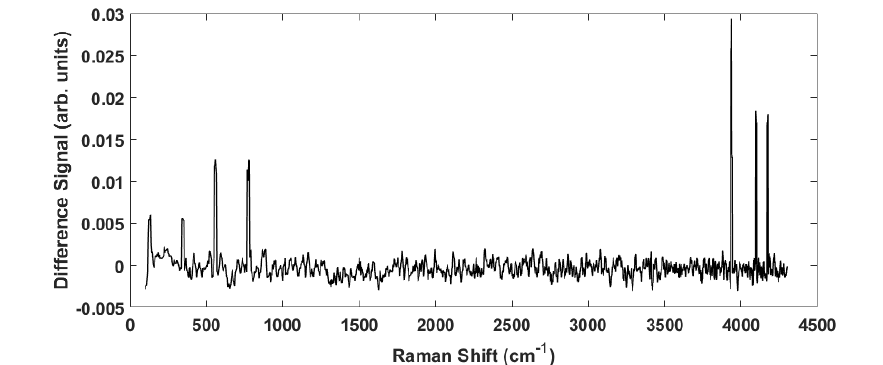
Figure 3. The difference spectrum obtained by subtracting the cancerous spectrum from the healthy spectrum in Figure 2. This spectrum highlights the peaks indicated